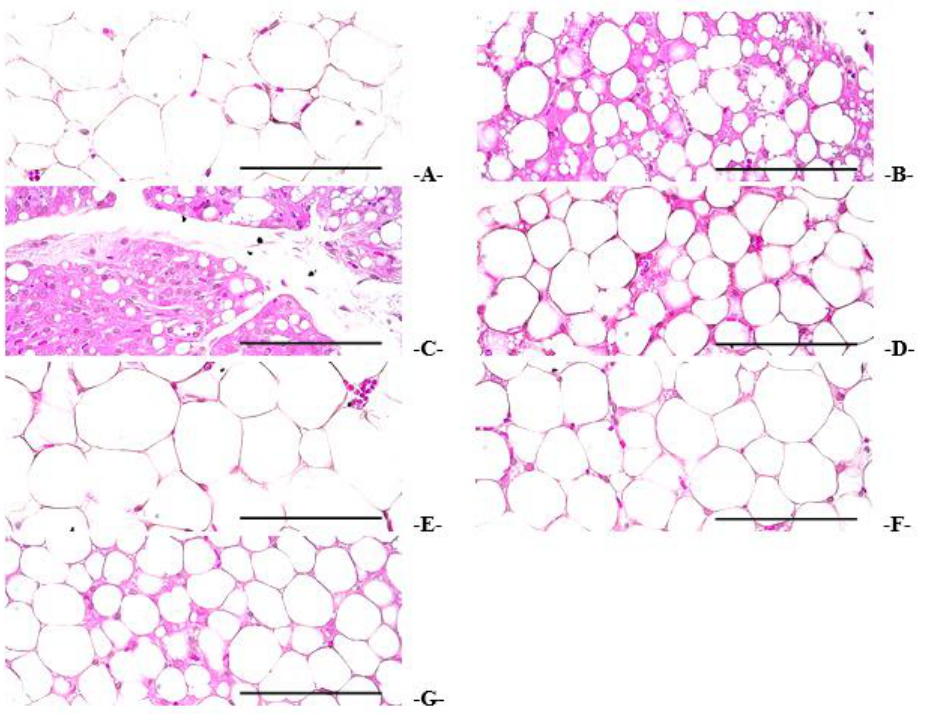
Figure 15. Representative histological profiles of the periovarian fat pads taken from intact or NCI-H520 tumor cell xenograft mice. ( A ) = Intact control; ( B ) = tumor-bearing control; ( C ) = gefitinib 120 mg/kg; ( D ) = SKOG 400 mg/kg; ( E ) = Gefitinib 120 mg/kg and SKOG 400 mg/kg; ( F ) = Gefitinib 120 mg/kg and SKOG 200 mg/kg; ( G ) = gefitinib 120 mg/kg and SKOG 100 mg/kg. AR = Adenophorae Radix; KOG = Kyeongokgo ; SKOG = sasam-Kyeongokgo . All Hematoxylin-Eosin-stained. Scale bars = 100 μm.